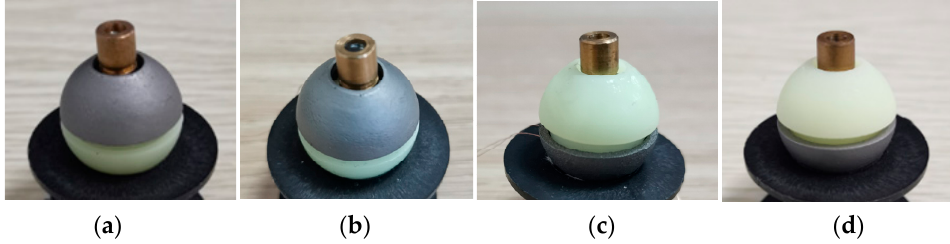
Figure 18. Four DSCR models with different centroid deviation. (a) l = 4 mm, (b) l = 2 mm, (c) l = − 2 mm, (d) l = − 4 mm.